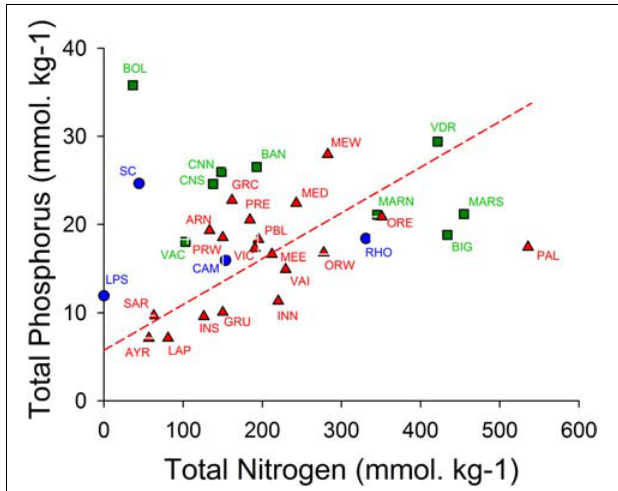
FIGURE 7 | Graph of total nitrogen (TN) and total phosphorus (TP) contents of the top 5 cm of the sediments expressed per dry weight (DW) of sediments. Oligohaline lagoons in blue circles, mesohaline lagoons in green squares and poly- and euhaline lagoons in red triangles (cf. Figure 2 ). A geometric mean regression was calculated for the poly- and euhaline lagoons and depicted as a broken red line (TP = 0.0519 × TN + 5.752 (mol · kg − 1 ), r = 0.494), corresponding to a N/P molar ratio of 19.27. Codes for sampling stations: AYR, Ayrolle; ARN, Arnel; BAN, Bagnas; PBL, Pierre Blanche; BIG, Biguglia; BOL, Bolmon; CAM, Campignol; CNN, CNS, Canet North and South stations, respectively; GRC, Grec; GRU, Gruissan; INN, Ingril Nord; INS, Ingril Sud; LAP, La Palme; LPS, La Palissade; MARN, La Marette; MED, Médard; MEE, MEW, Méjean, East and West stations, respectively; ORE, ORW, Or East and West stations, respectively; PAL, Palo; PRE, PRW, Prévost, East and West stations, respectively; RHO, Rhône de Saint Romans; SC, Scamandre; VAI, Vaïne; VDR,